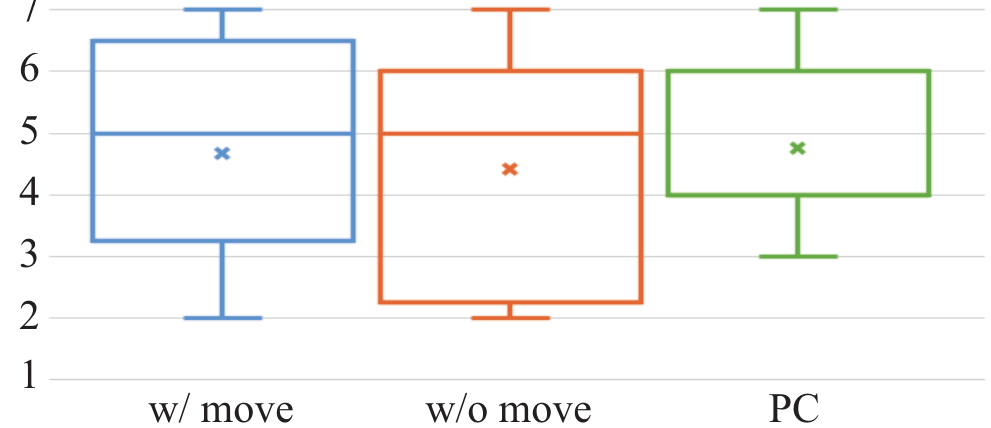
Figure 4. Results (“Did you feel that you had actually been to the shopping district before?”).